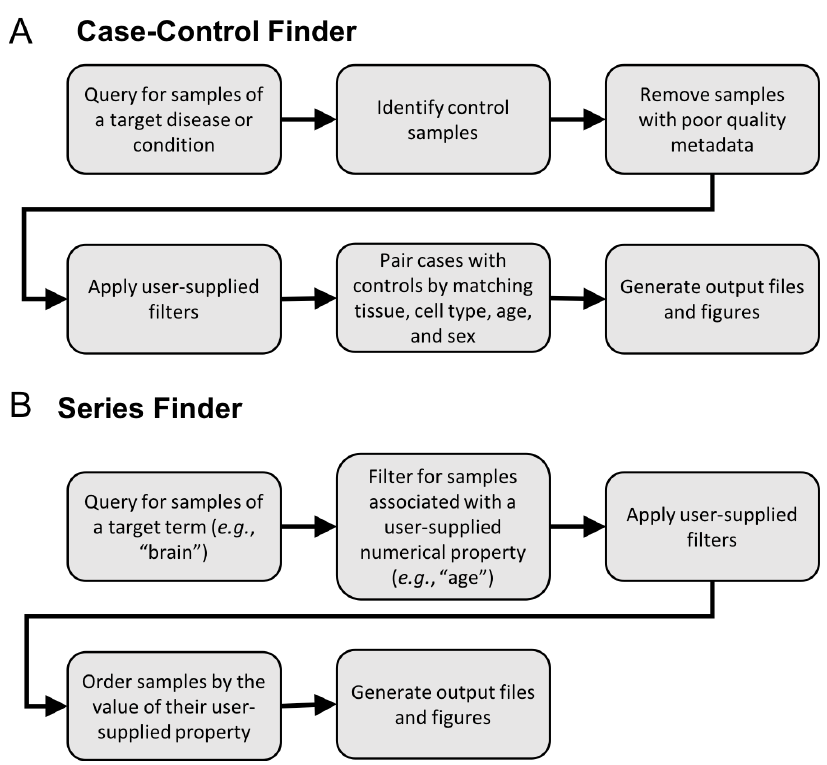
Figure 1. Data flows for hypothesis-driven query tools. An overview of the backend processing functions called from the Jupyter notebooks.